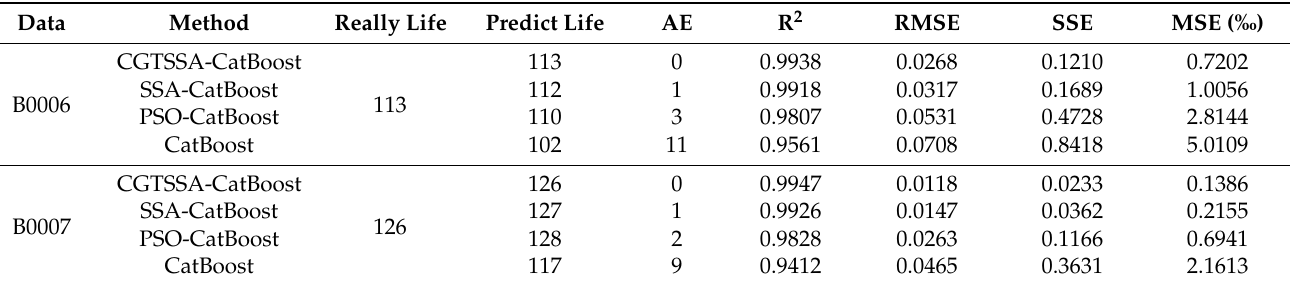
Table 3. Detailed prediction results of various